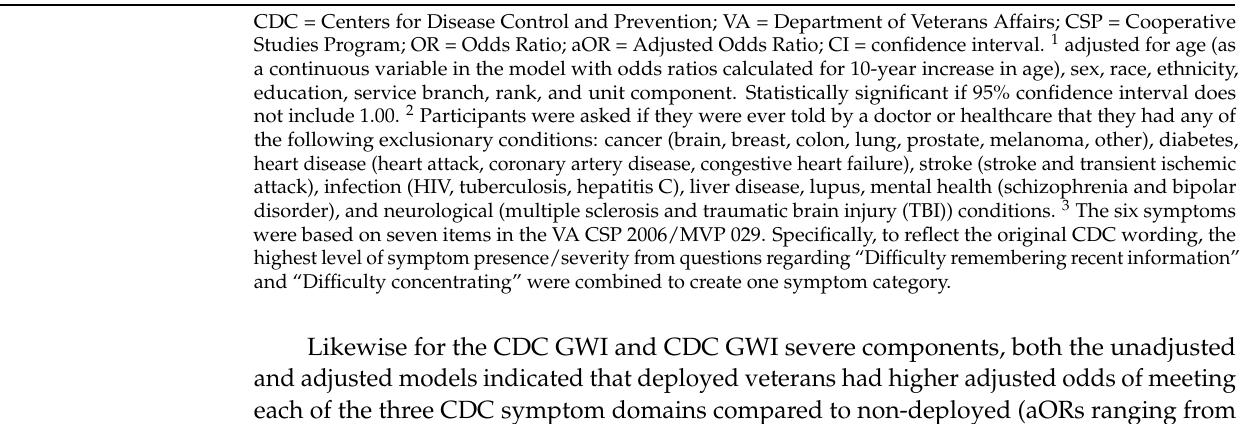
Association with